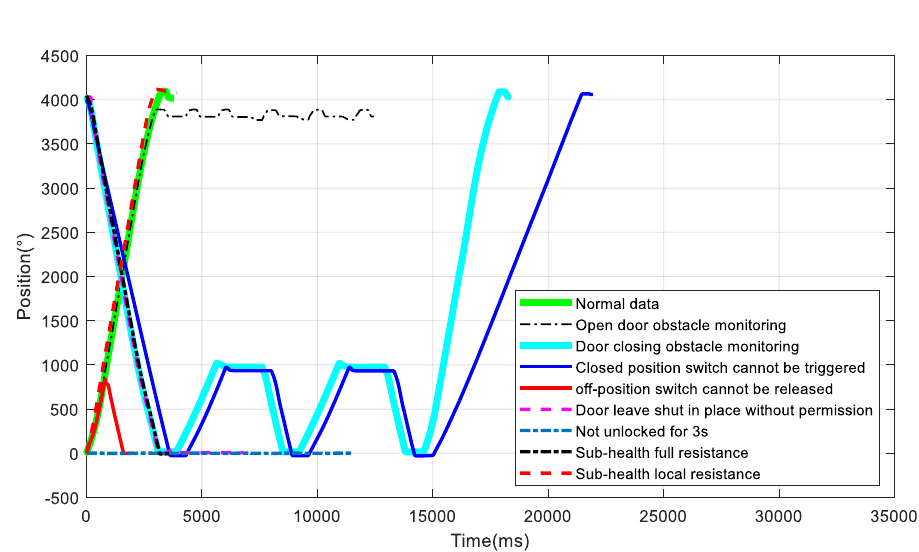
Fig. 3 Motor’s angle data: comparison of typical faults and subhealth data with normal data